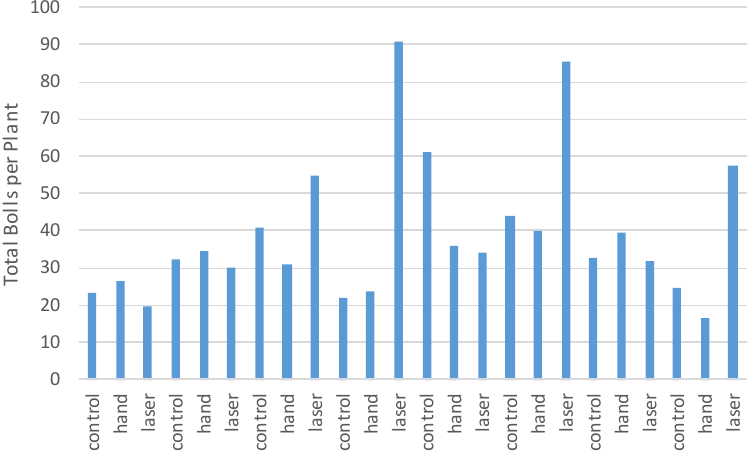
Figure 12. Boll counts for greenhouse-grown plants utilizing large 11 L pots.